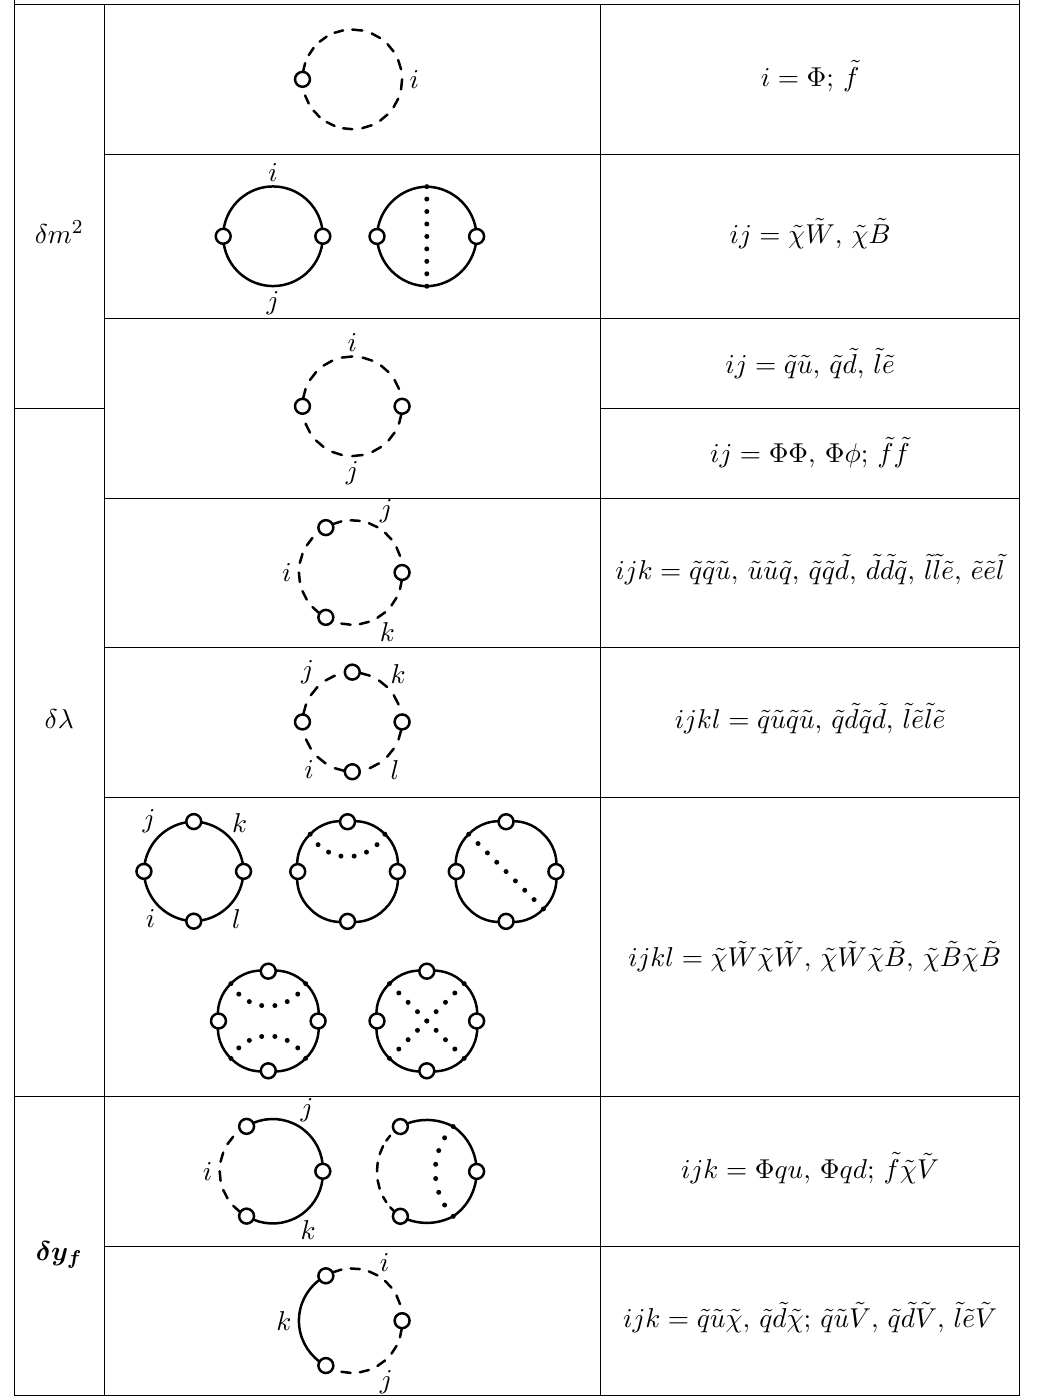
Table 6 . Covariant diagrams contributing to Higgs potential and Yukawa interactions.